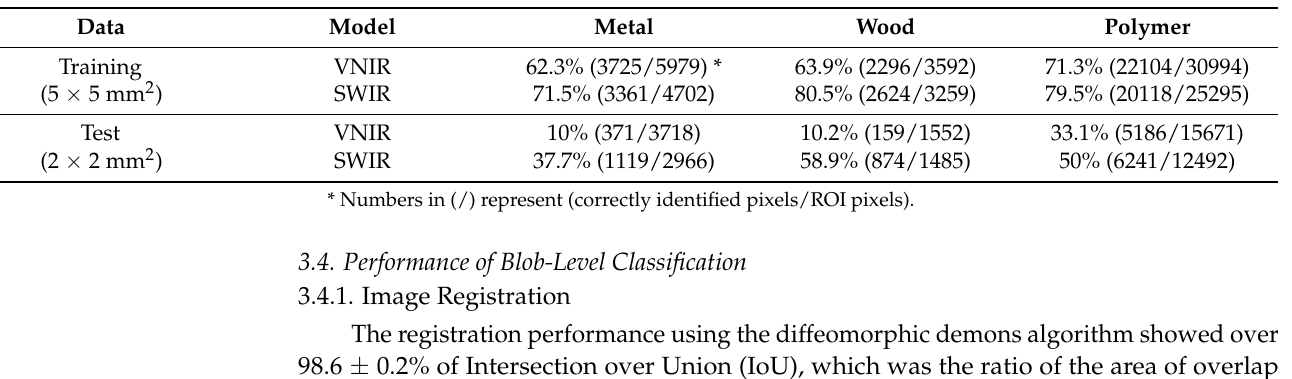
Table 2. Foreign material detection rates (%) based on pixel-level classification.